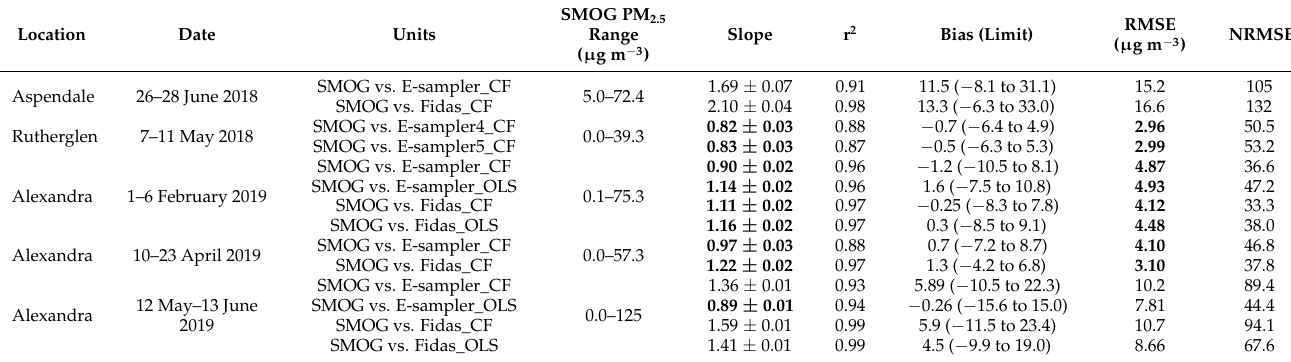
Table 5. Summary statistics of hourly PM 2.5 concentrations measured during smoke plume